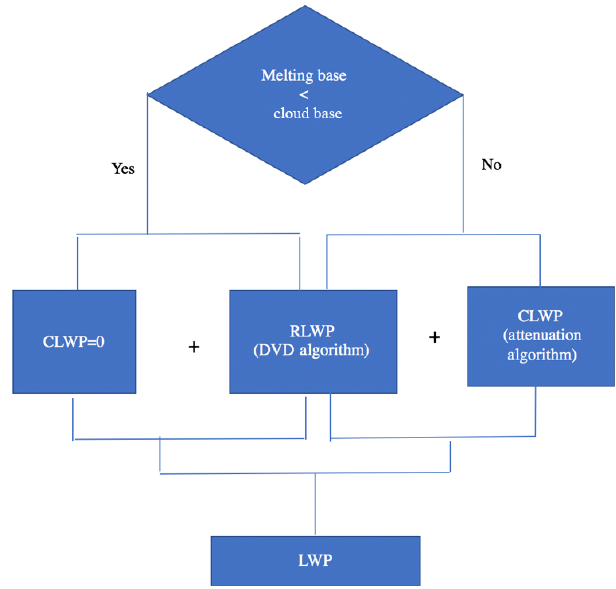
Figure 2. Algorithm flowchart to retrieve liquid water path (LWP) below the melting